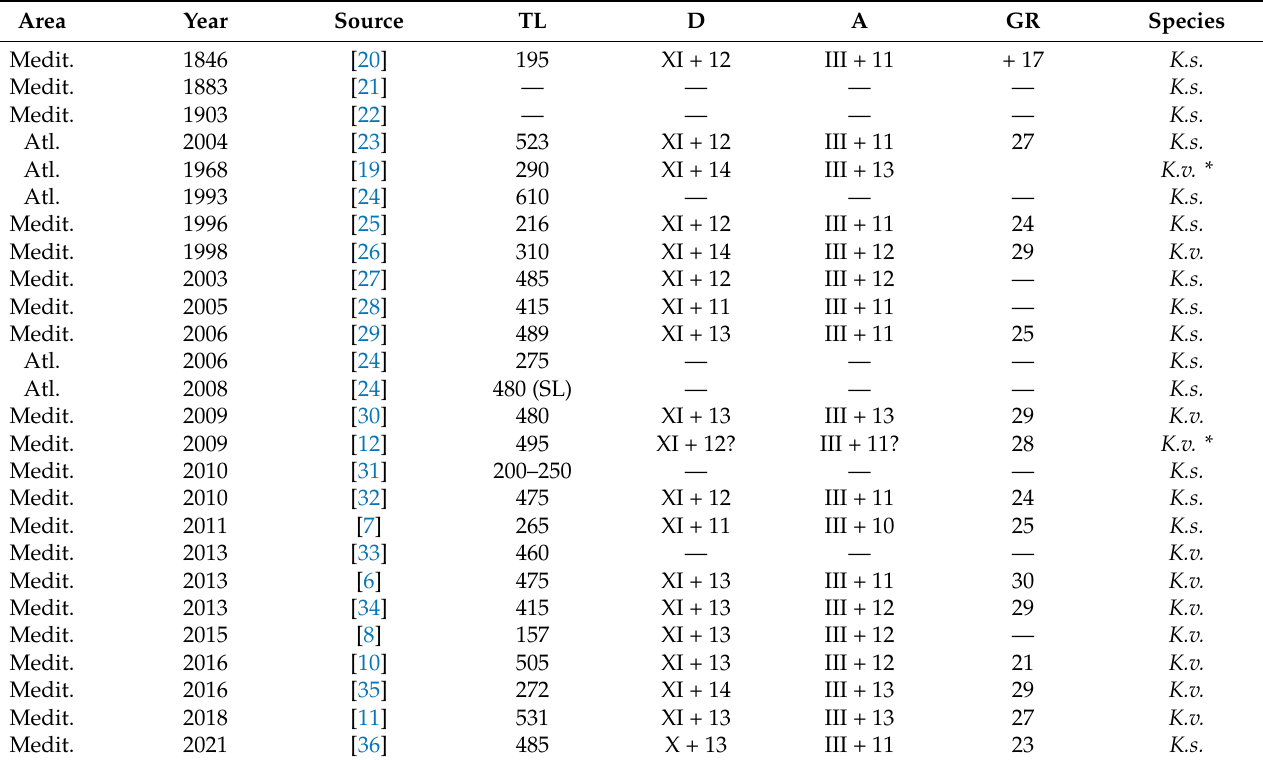
Historical records of Kyphosus specimens in NE Atlantic–Mediterranean area, ex- cluding Galician records, with its morphological characterization. TL in mm, Atl. = At- lantic Ocean, Medit. = Mediterranean Sea, K.s . = Kyphosus sectatrix , K.v . = Kyphosus vaigiensis . (*) Originally misidentifications.